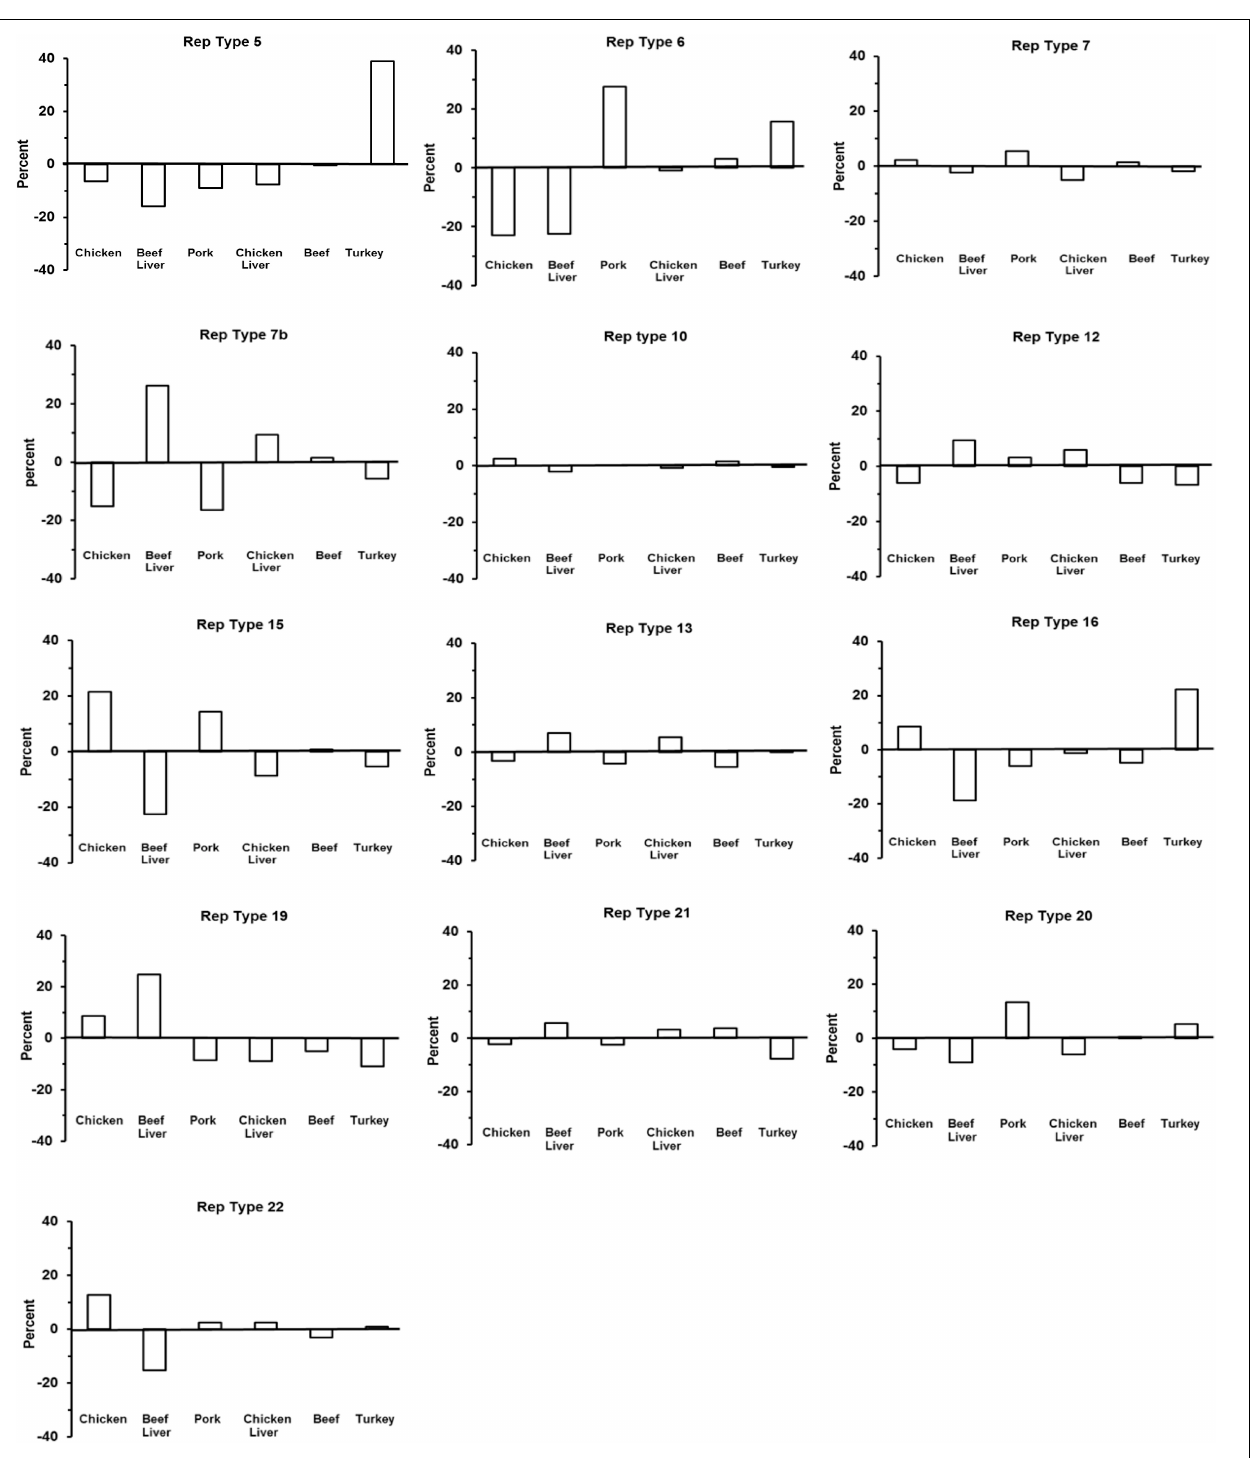
FIGURE 5 | The distribution of 13 rep families in S. aureus from six different meat sources. This chart is a visual representative for the chi-square results in Table 2 .